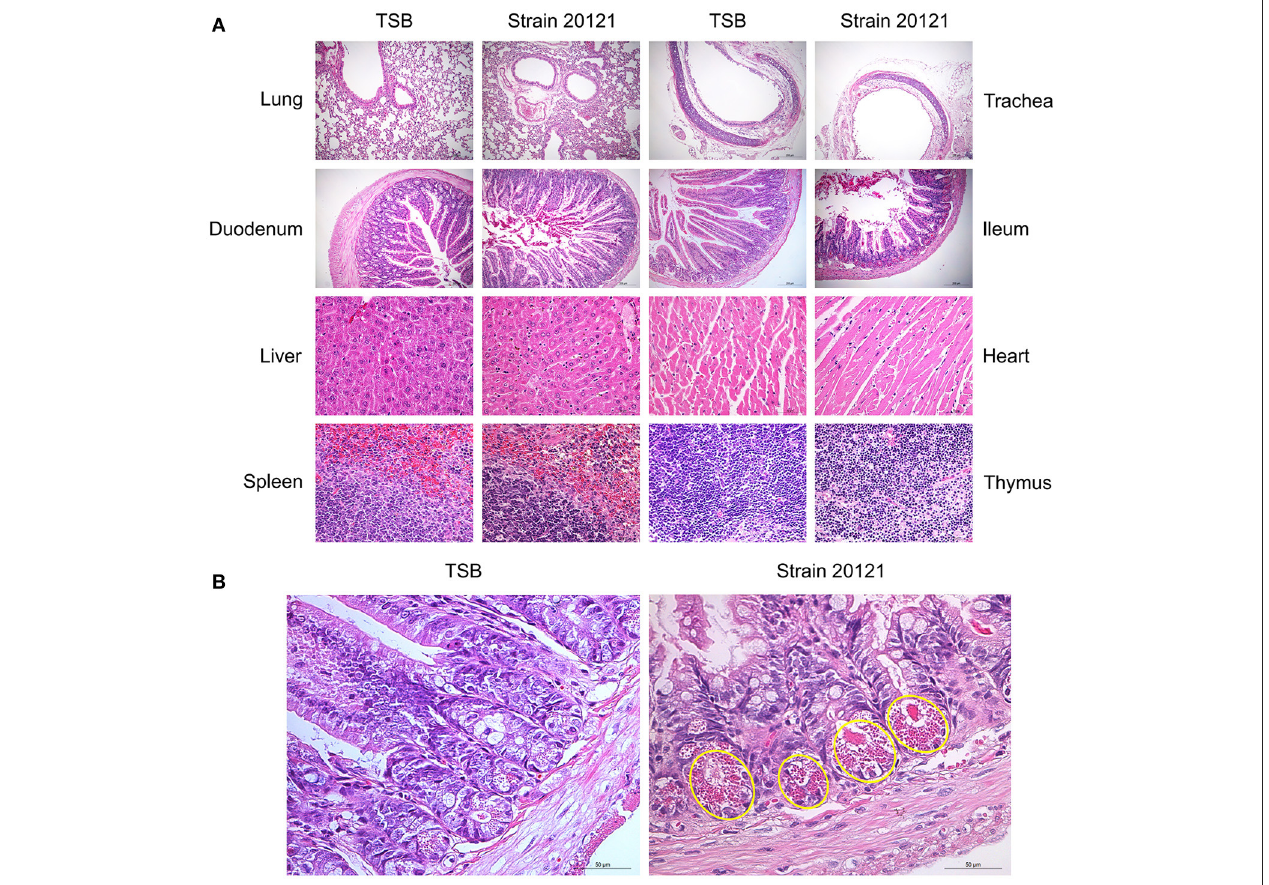
FIGURE 4 | Organ histopathology in mice infected with T. pyogenes . (A) Mice were infected with 2 × 10 6 CFU of T. pyogenes strain 20121 or inoculated with tryptic soy broth (TSB) as control. Lung, trachea, duodenum, ileum (scale bars = 200 µ m), liver, heart, spleen and thymus (scale bars = 50 µ m) were collected on 2 dpi for observation of histopathological lesions. (B) Ileum at 2 dpi, showing degeneration of mucosal epithelial cells, necrosis and sloughing, and Paneth cell degeneration (yellow oval); scale bars = 50 µ